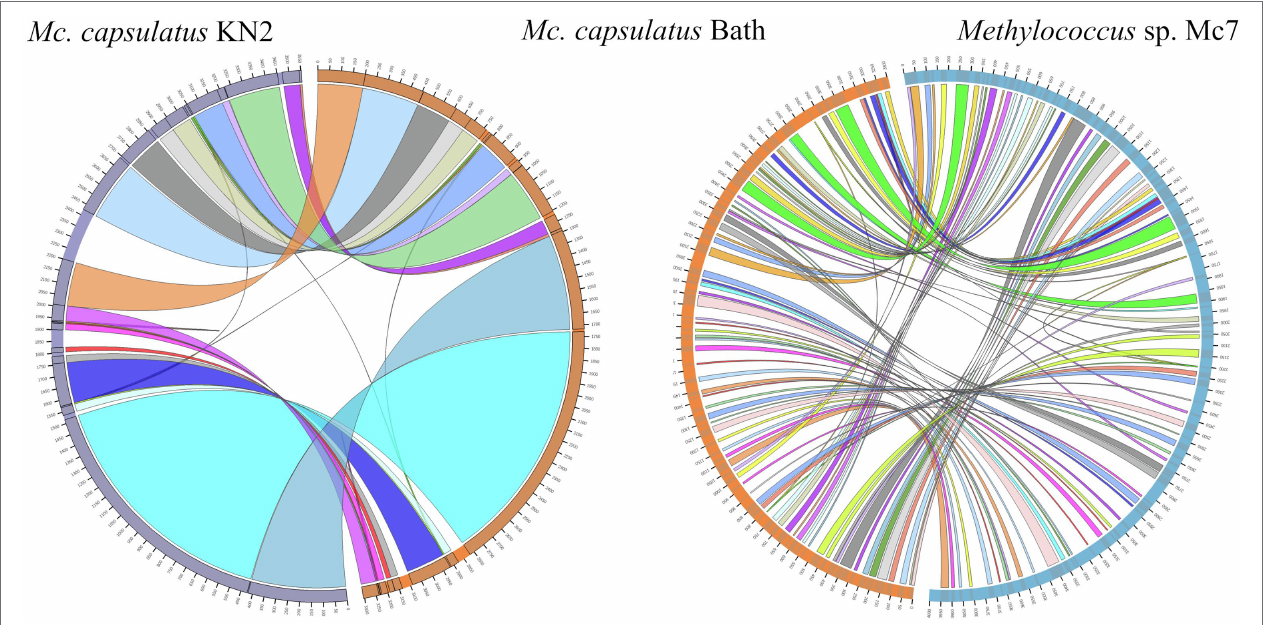
FIGURE 5 | Visualization of synteny blocks between Methylococcus capsulatus Bath, Methylococcus capsualtus KN2, and Methylococcus sp. Mc7. Each link represents a single synteny block. Each circle is divided into two parts, which represent two compared genomes. The genome of Methylococcus capsulatus Bath is shown in orange, while the genomes of Methylococcus capsulatus KN2 and Methylococcus sp. Mc7 are displayed in purple and blue,